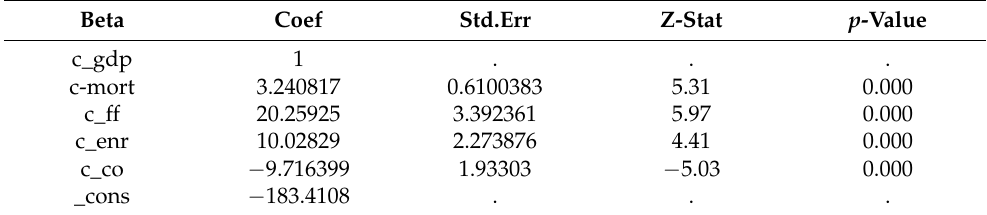
Table 11. Johansen normalization restriction imposed for China.